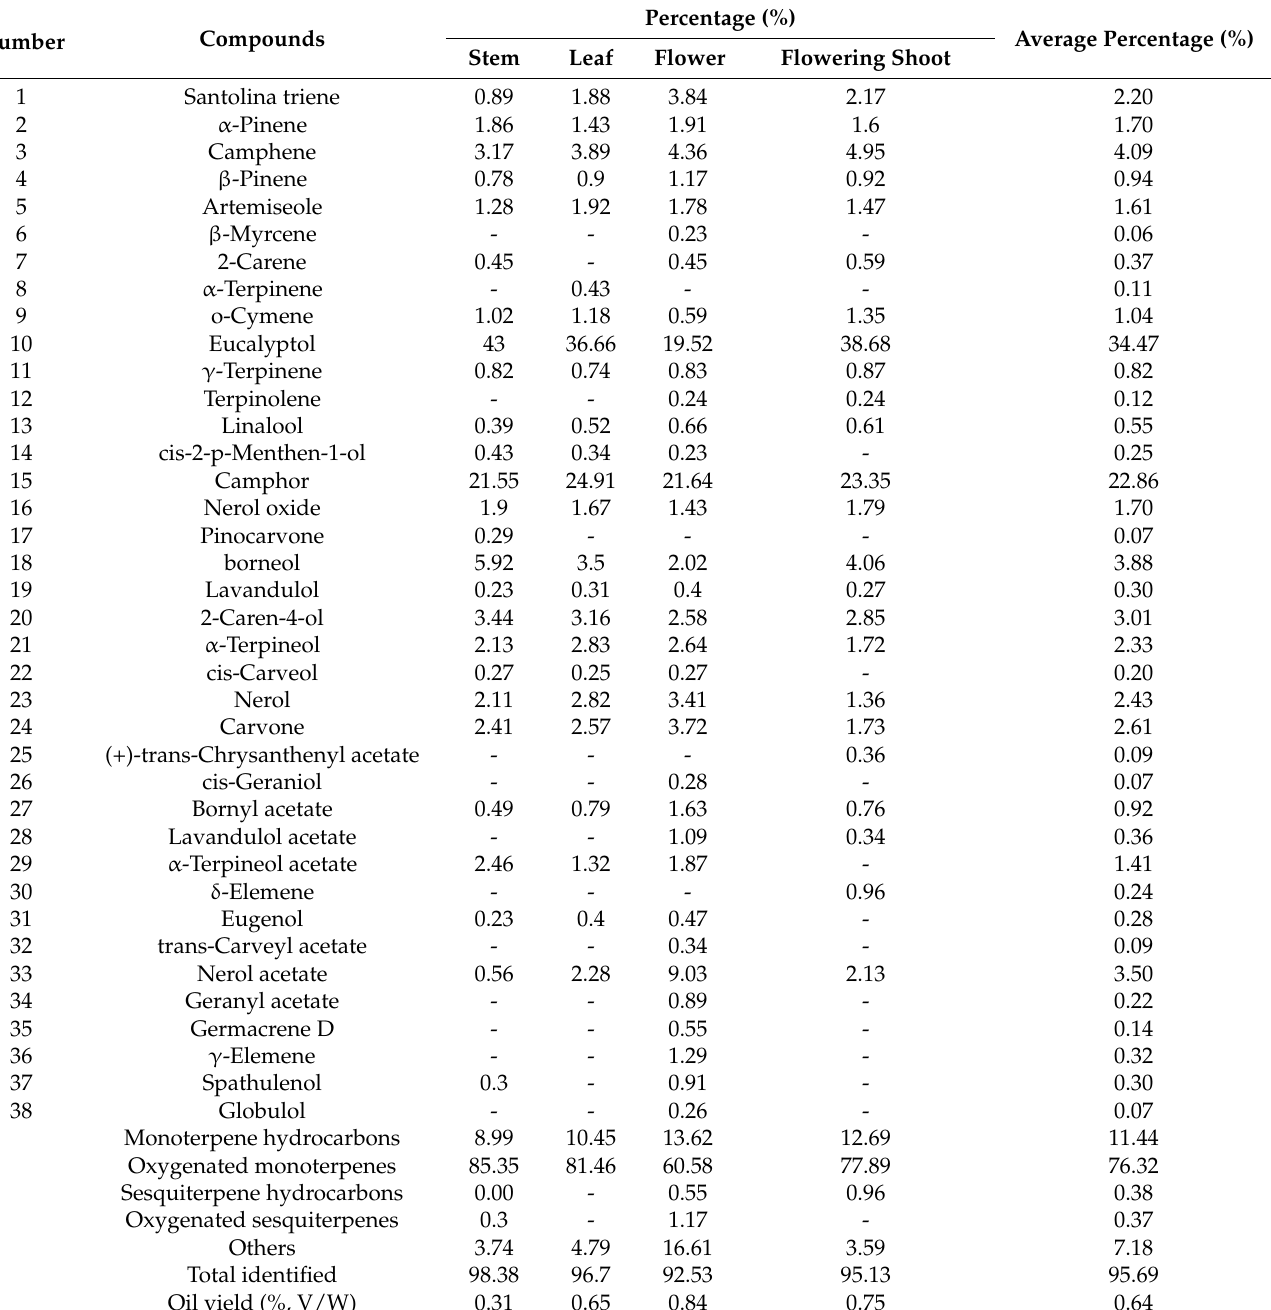
Table 1. Chemical composition of the volatile